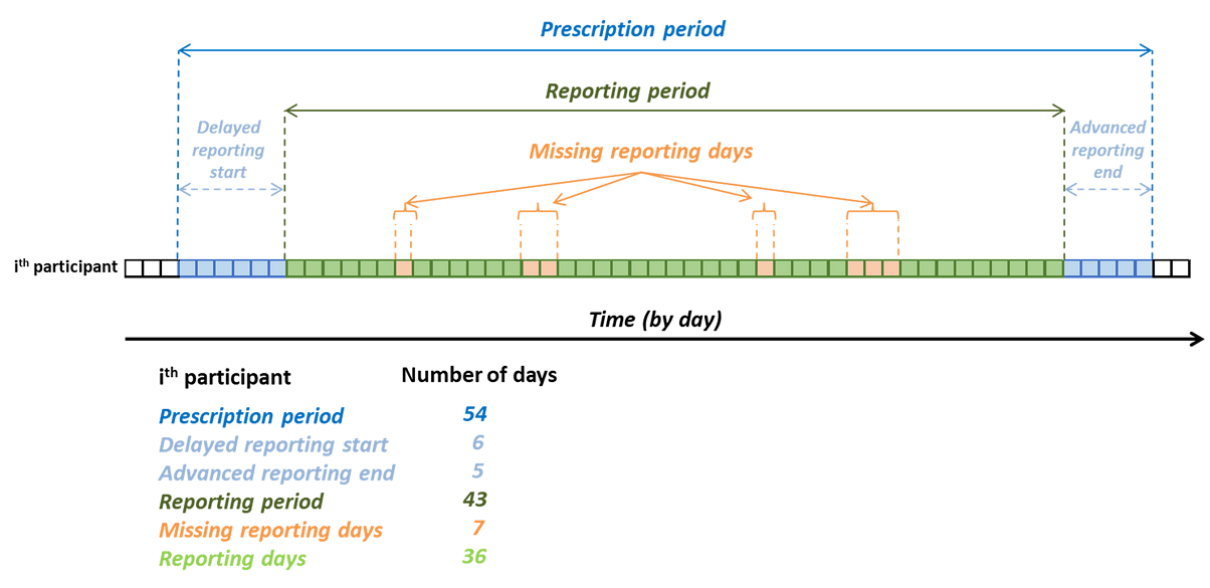
Figure 1. Graphical representation of definitions used in this study. The box line represents the monitored period (each box is a specific day) of a hypothetical participant. In this example the medical doctor, according to the individual participant’s clinical history, invited the patient to fill in the e-diary questionnaire for 54 days (prescription period). The patient started to record symptoms 6 days after the prescribed beginning day (delayed reporting start) and finished recording symptoms 5 days before the prescribed ending day (advanced reporting end). Thus, the reporting period lasted 43 days, during which the participant did not fill in the e-diary questionnaire for 7 days (missing reporting days). Overall, the participant filled in the e-diary questionnaire for 36 days (reporting